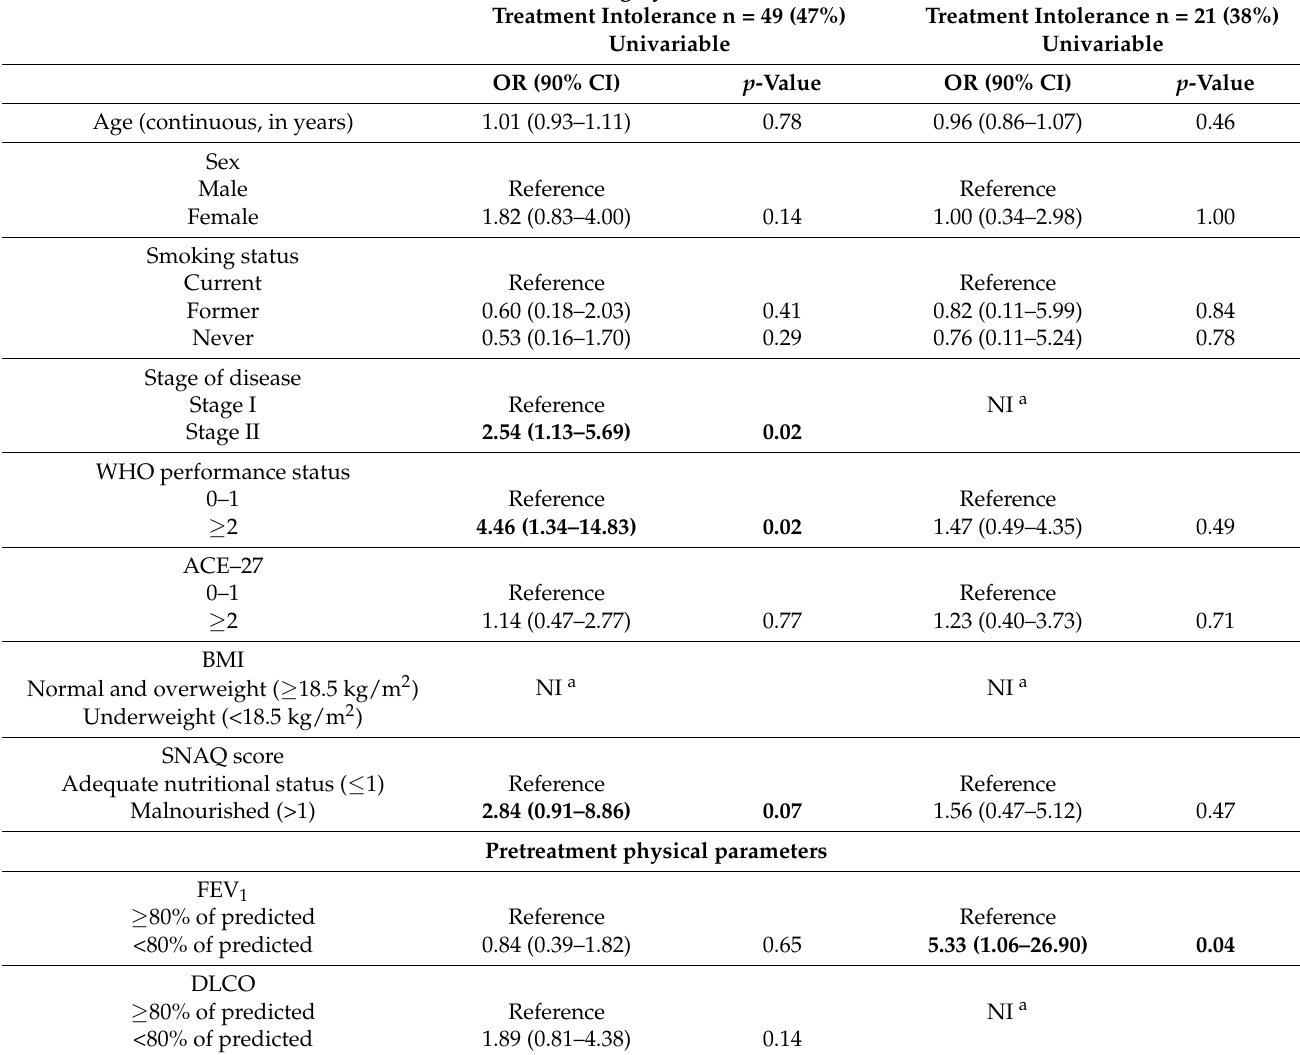
Table 4. Univariable odds ratios for associations of pretreatment patient characteristics, physical parameters, and geriatric parameters with intolerance of treatment in patients with stage I–II NSCLC, stratified for type of